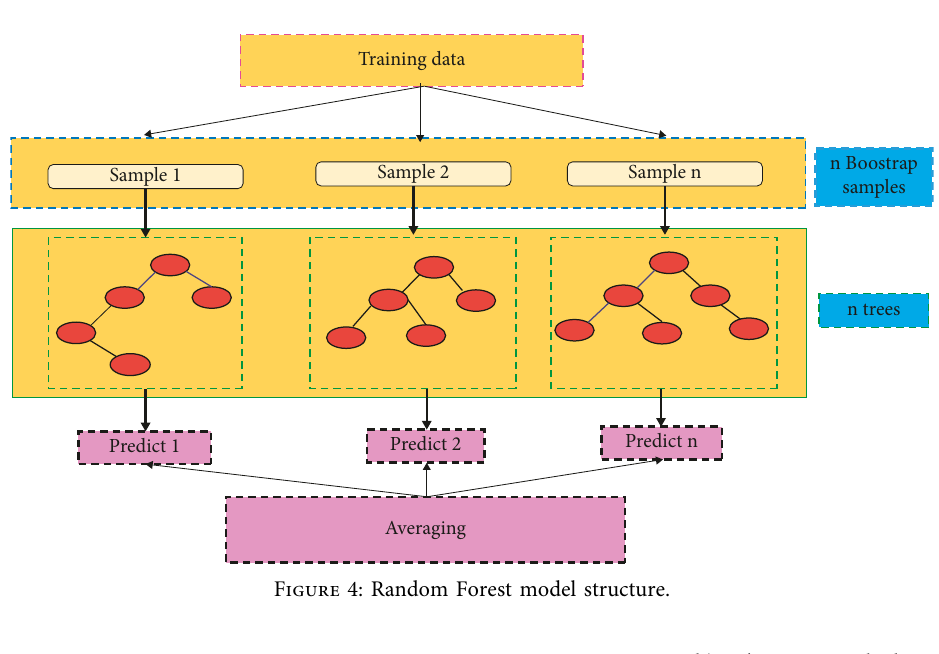
Figure 4: Random Forest model structure.